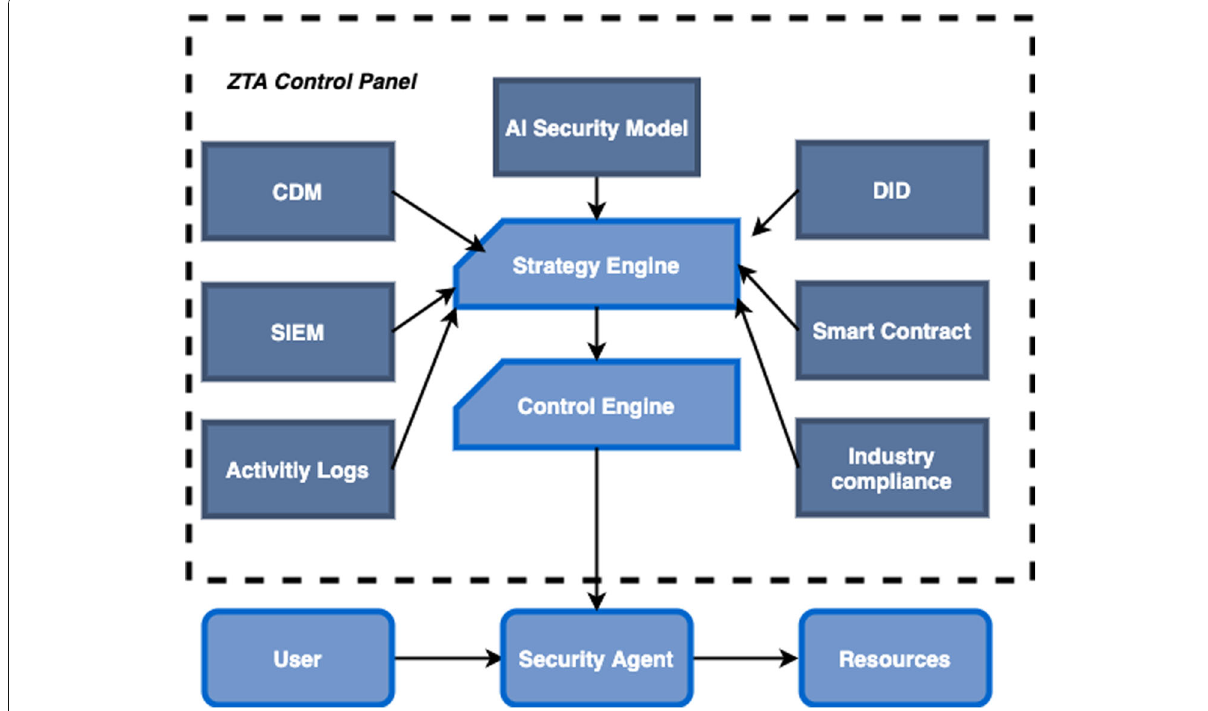
Fig. 5 Security management in OpenIaC based on zero trust